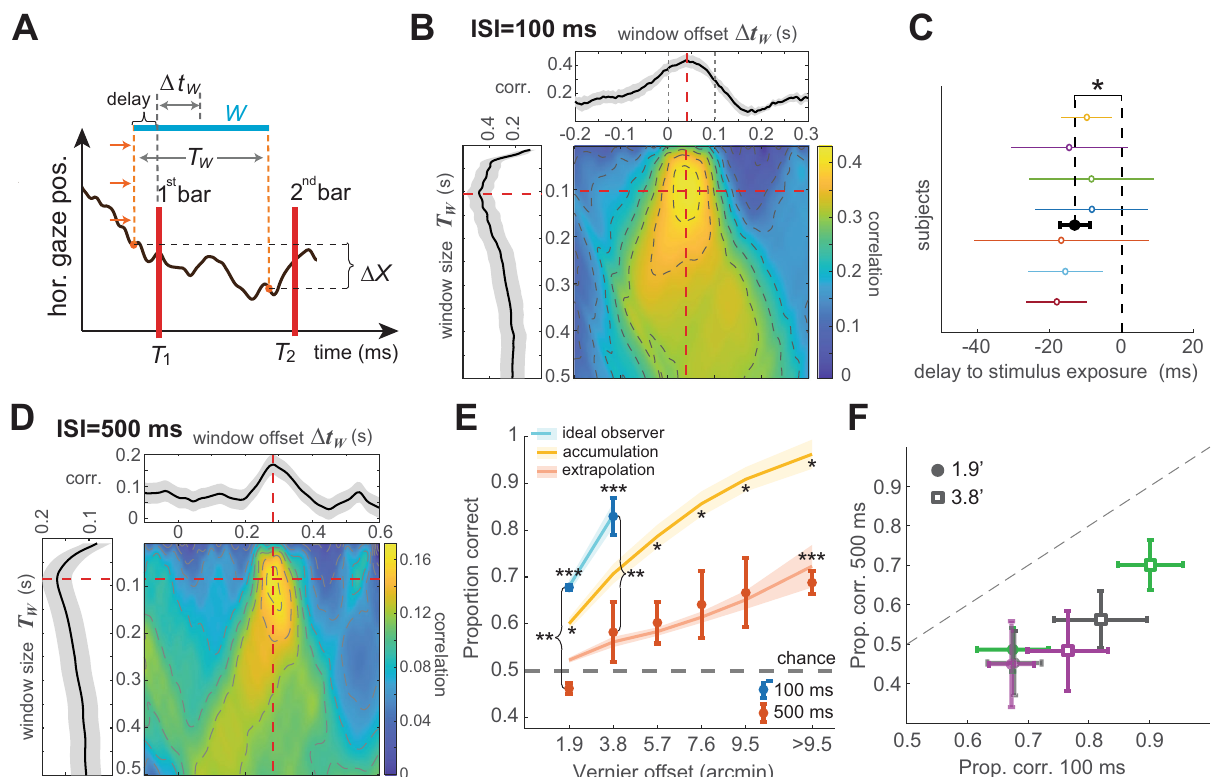
Fig. 4 | Characteristics of the extraretinal signal. A Determination of the hor- circle; * p =1.52×10 − 4 , two-tailed t-test). Error bars represent±one SD. Þ(cid:2) X ð Δ t W (cid:2) T W Þ that best correlates E Comparisonofperformancewith100and 500msISIs.Performancewaslowerin izontal gaze displacement Δ X = X ð Δ t W + T W 2 2 with perceptualreports. T W represents the duration of the window of observation, the 500 ms condition (** p <0.005, paired one-tailed t-test) and improved margin- Δ t W the temporal lag between the onset of the fi rst bar and the window center. ally with increasing Vernier offset (***above chance; p <0.009, one-tailed t-test). B – F Results obtained with a 100 ms ISI (panels B , C , N =7 subjects) and with a 500 Empirical data are consistent with the prediction from the ideal observer model ms ISI (panels D – F , N =3 subjects). Data were collected using the custom LED with σ E adjusted to increase proportionally to time (red curve) and lower than ffiffi p t display with 5 ms fl ashes. B , D Correlation between Δ X and perceptual reports asa (yellowcurve;* p <0.037, one-tailedpairedt-test). predicted byincreasing σ E / function of both window parameters ( T W ; vertical axis) and ( Δ t W ; horizontal axis). Note that these fi ts have no free parameters: all parameters were obtained from The highest correlation isachievedfor a 100 ms window that slightly precedes the those estimated over the 100 ms ISI in Fig. 3. Error bars and shaded regions fi rst bar. Side plots are sections at the optimal T W and Δ t W (red dashed lines). represent±one SEM. F For each observer (different colors) performance at both Shaded regions represent±one SEM across subjects. C The timing of maximum 1.9 0 and 3.8 0 gaps was always lower in the 500 ms condition ( p <0.027, one-tailed bootstraps over an average of N =87 trials across subjects and gaps). Error bars correlation for each individual subject. On average, subject responses are best represent±one SEM. Source data are provided as a Source data fi correlatedwitha100-mswindowthatanticipatedthestimulusby13ms( fi lledblack